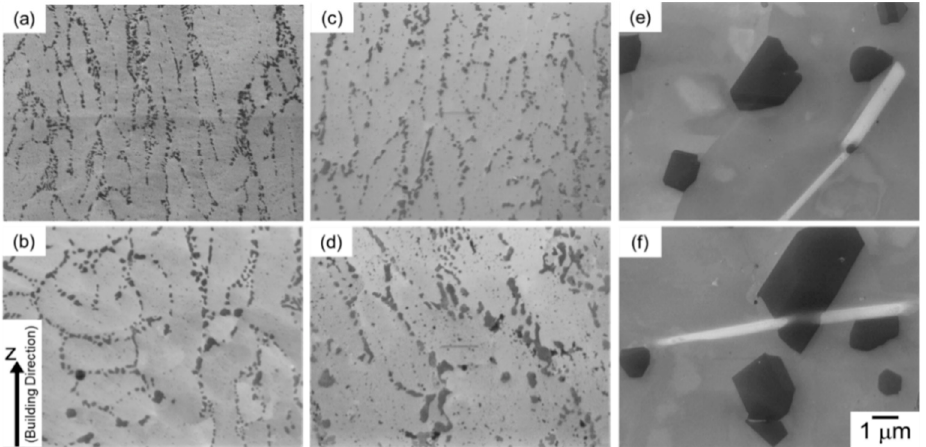
Figure 3. SEM micrographs of the microstructures taken from the node portion of the lattice specimen with different vertical distances from the geometric center: ( a , c , e ) d N = 0.8 mm and ( b , d , f ) d N = − 0.8 mm; ( a , b ) as-manufactured, ( c , d ) annealed at 300 ° C for 2 h, and ( e , f ) solution heat treated at 530 ° C for 6 h.